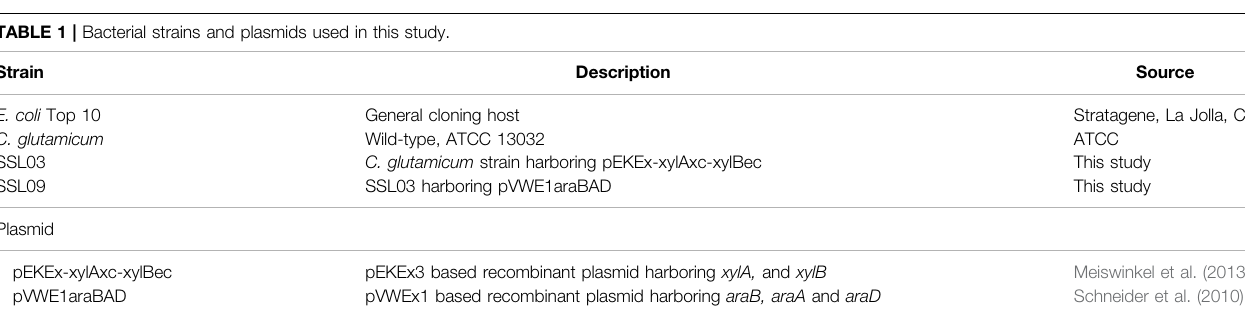
TABLE 1 | Bacterial strains and plasmids used in this